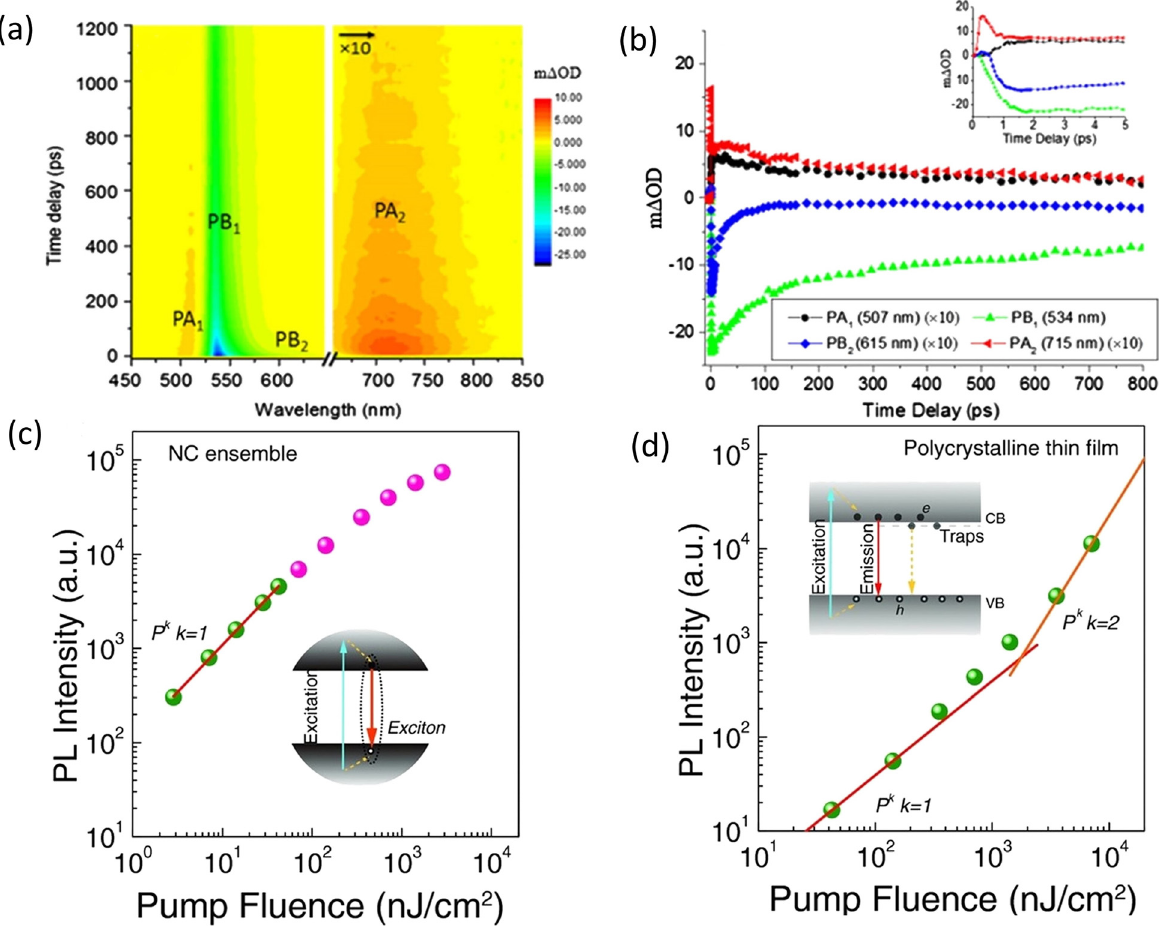
Figure 1: (a) CH 3 NH 3 PbBr 3 transient absorption (TA) spectra [28] (b) dynamics locus [28] (c) FAPbI 3 nanocrystals [31] (d) FAPbI 3 polycrystalline thin fi lm